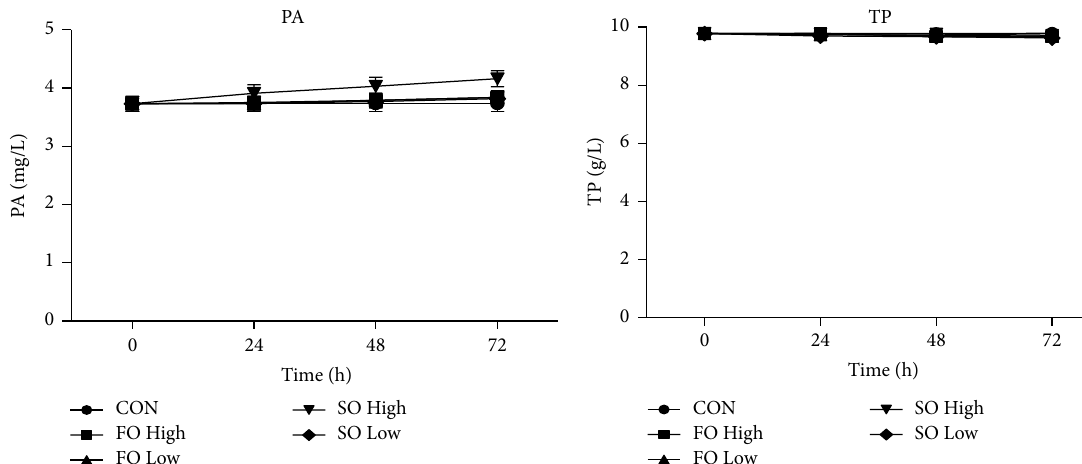
Figure 1: High concentrations of soybean oil affect hepatocyte function. Primary hepatocytes were treated with 0.4% or 1% soybean or fish oil-based lipid emulsions and several biochemical parameters were analyzed at the indicated time points to determine hepatic function; ∗ 𝑝 < 0.05 versus CON. TBIL, total bilirubin; DBIL, direct bilirubin; ALT, alanine aminotransferase; AST, aspartate aminotransferase; 𝛾 -GT,